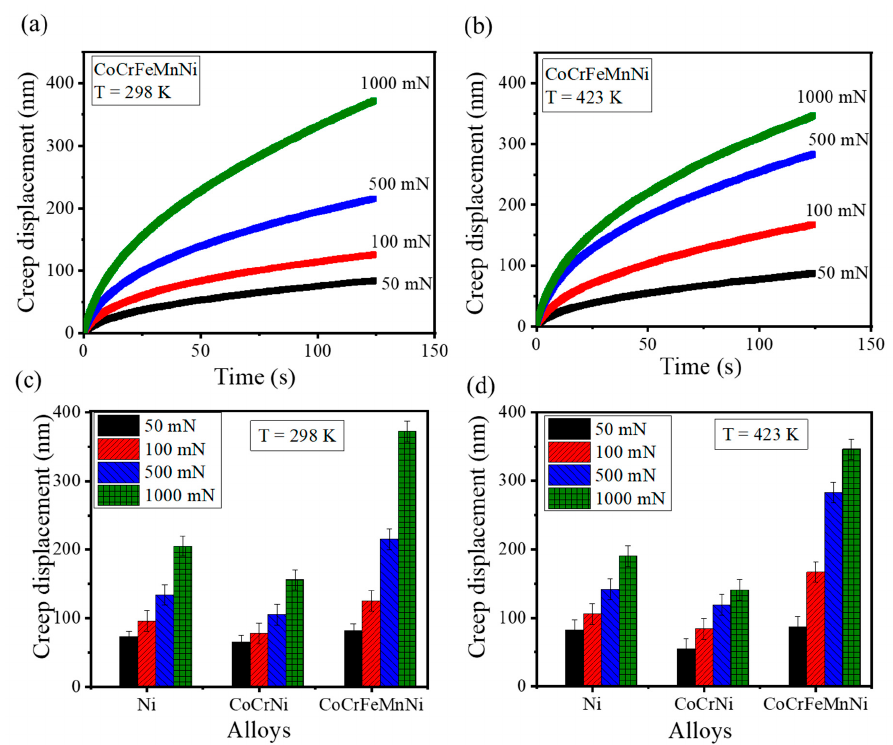
Figure 3. Representative creep displacement versus hold time for CoCrFeMnNi alloy as a function of loads at ( a ) 298 K and ( b ) 423 K. Maximum creep displacement for the three alloys at ( c ) 298 K and ( d ) 423 K showing larger creep depth with increase in load.